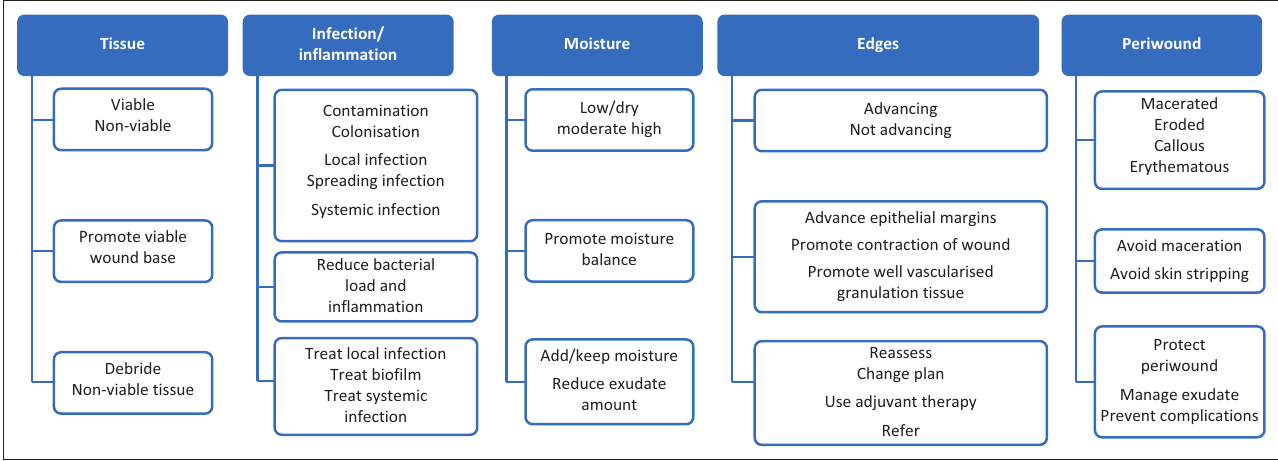
FIGURE 4: Wound bed preparation and treatment plan: Assessment, objectives and action.